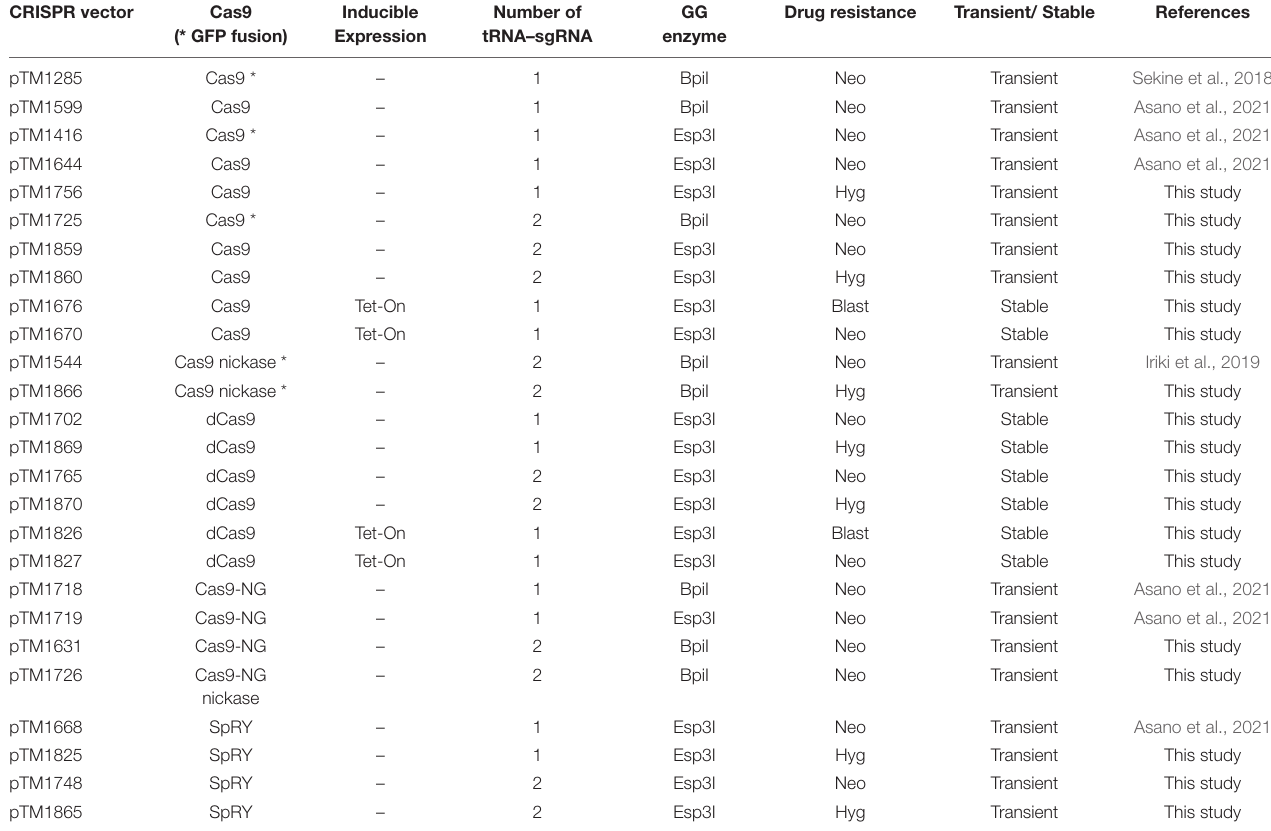
TABLE 2 | CRISPR/Cas9